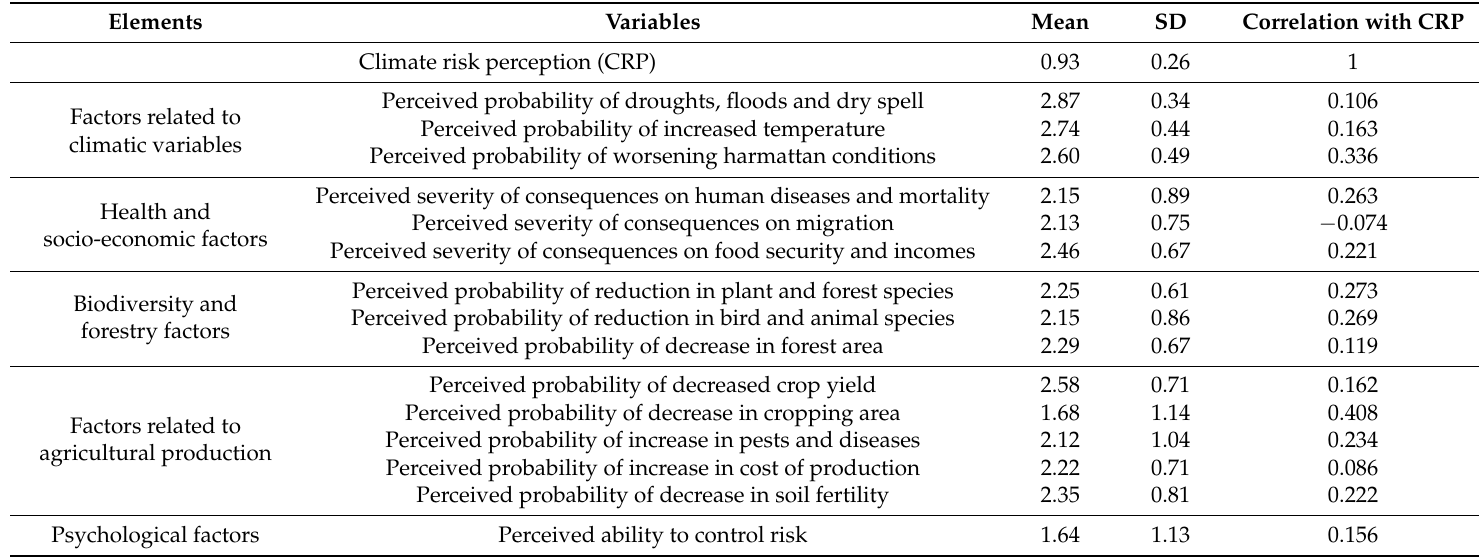
Table 3. Descriptive statistics of predictors and mean score of climate change risk